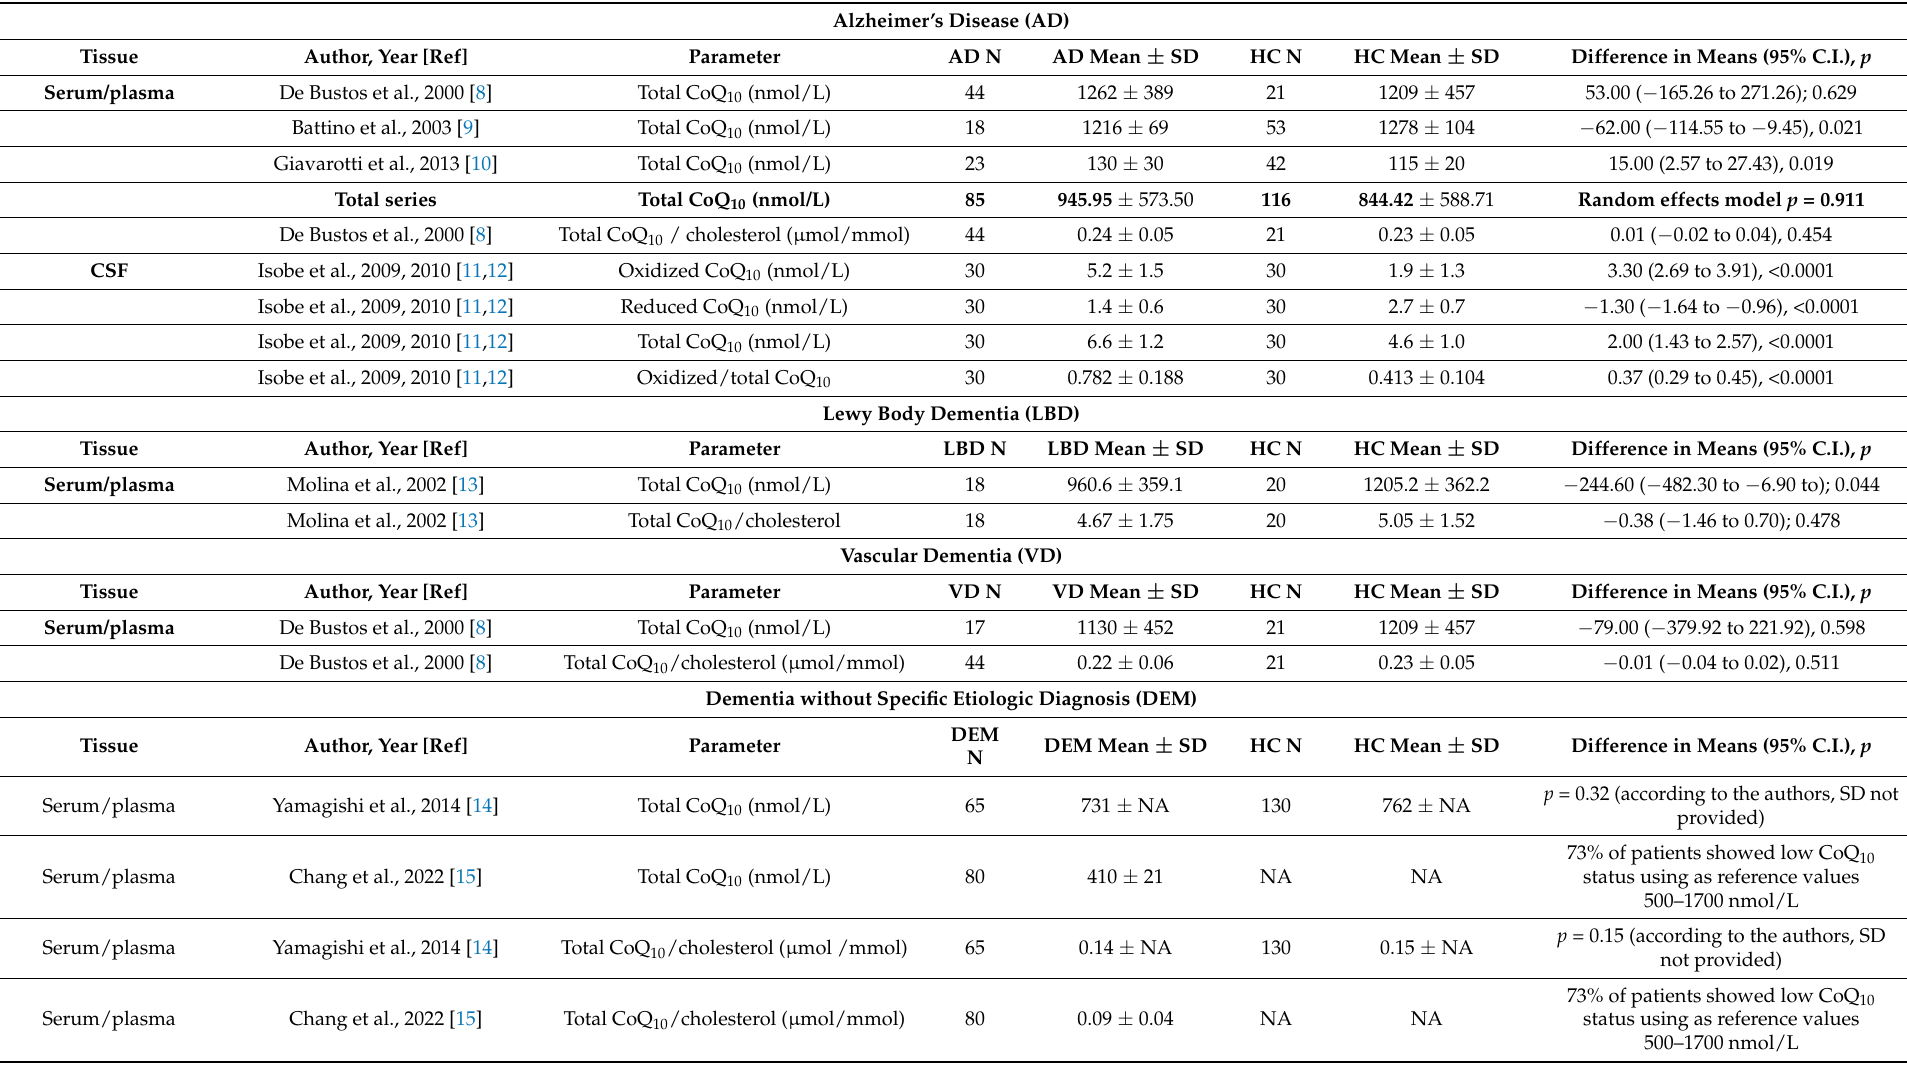
Table 1. Coenzyme Q 10 concentrations in several tissues from dementia patients and healthy controls